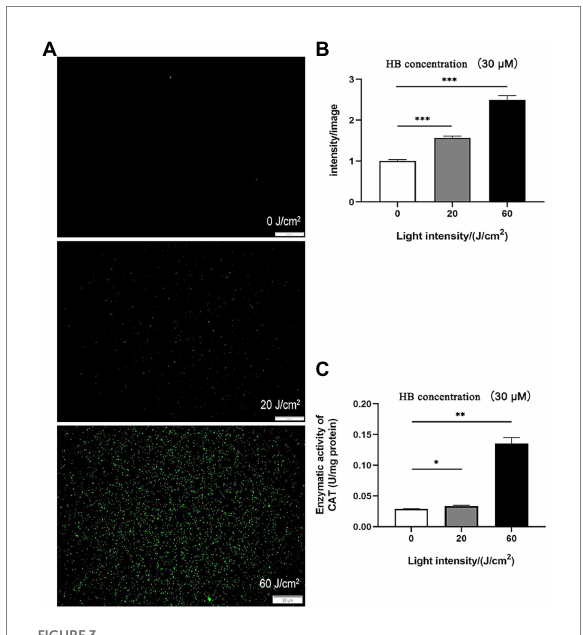
FIGURE 3 ROS stimulated by aPDI on C. sakazakii . Intracellular ROS was analyzed using DCFH-DA staining in C. sakazakii cells, in response to aPDI with 30 μ M HB irradiated by various light doses. In addition to representative microscopy images (A) , fluorescence intensity (B) was quantified using Image J software. Scale bar represents 50 μ m. In addition, enzymatic activity of catalase (C) was also examined to assess the bacterial antioxidative response. CAT, catalase. Values are the mean ± SEM (standard error of mean) from 3~4 replicates. * p < 0.05, ** p < 0.01, *** p <